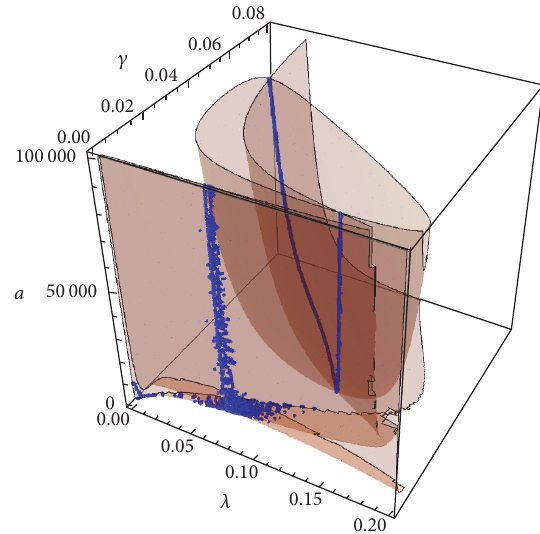
Figure 1: The blue curves are the solutions of (10) and (13). A is symbolizedas“ 𝑎 ”inthe3Dplot.Therearetwobranchesofsolutions, of which the U-shaped curve is excluded on physical grounds. The other curve is the only feasible solution which has a broadening due to graphical impreciseness of the plot. (See the